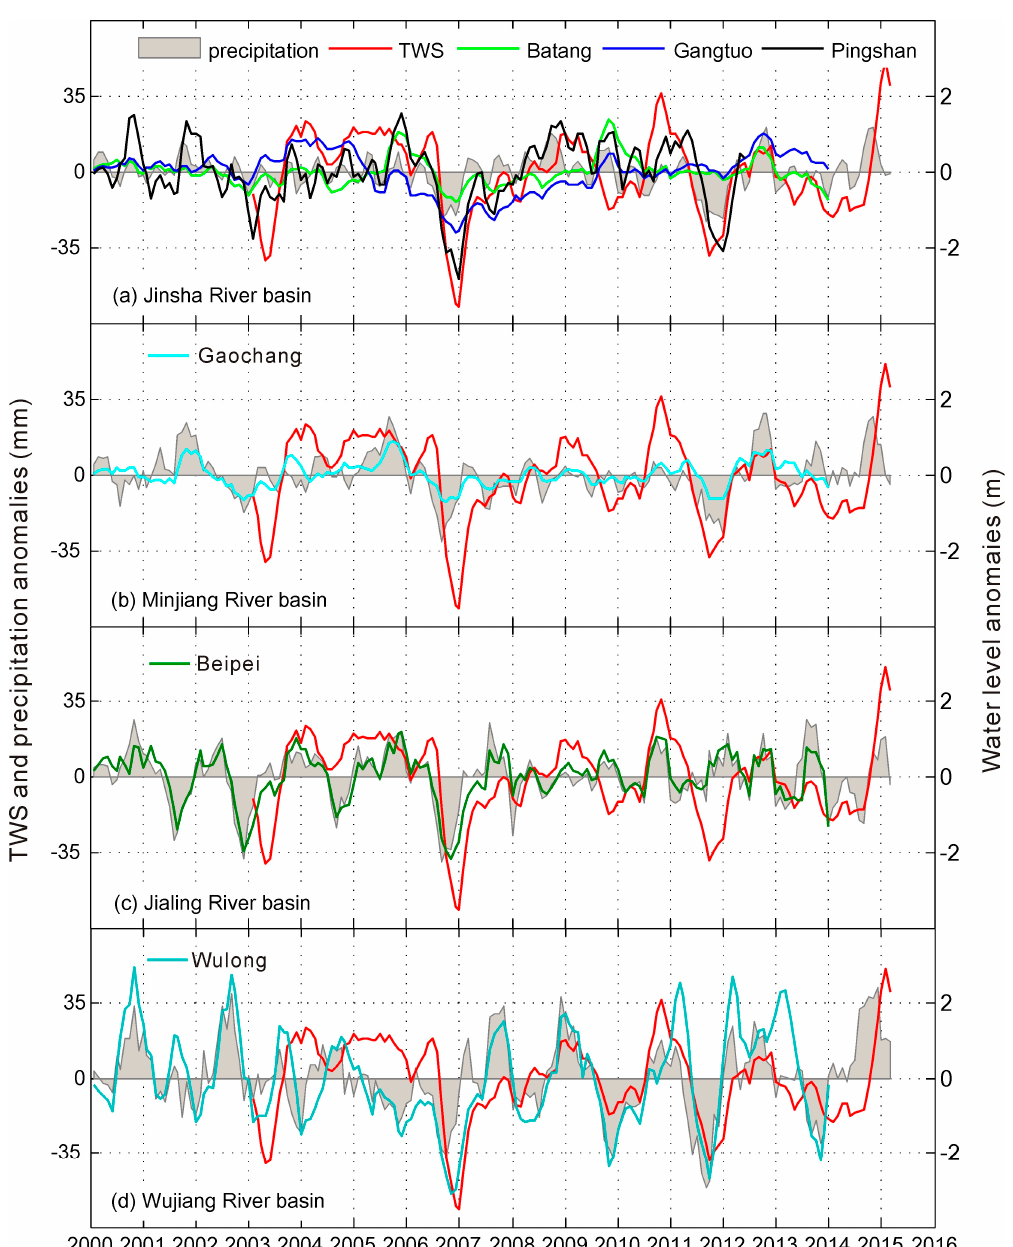
Figure 6. Figure 6. Time series of non-seasonal anomalies in the Sichuan Basin TWS, and river level/precipitation in the ( a ) Jinsha River basin; ( b ) Mijiang River basin; ( c ) Jialing River basin; and ( d ) Wujiang River